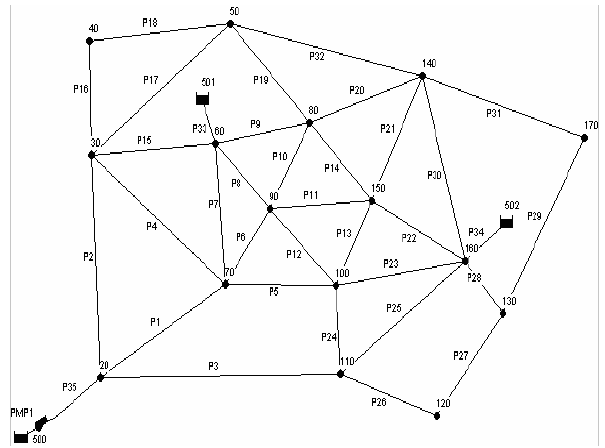
Figure 2. Basic framework of Decision Support